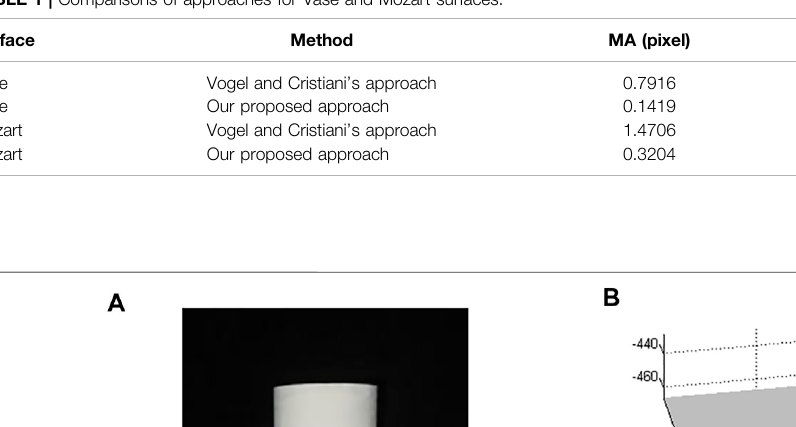
Frontiers in Physics |